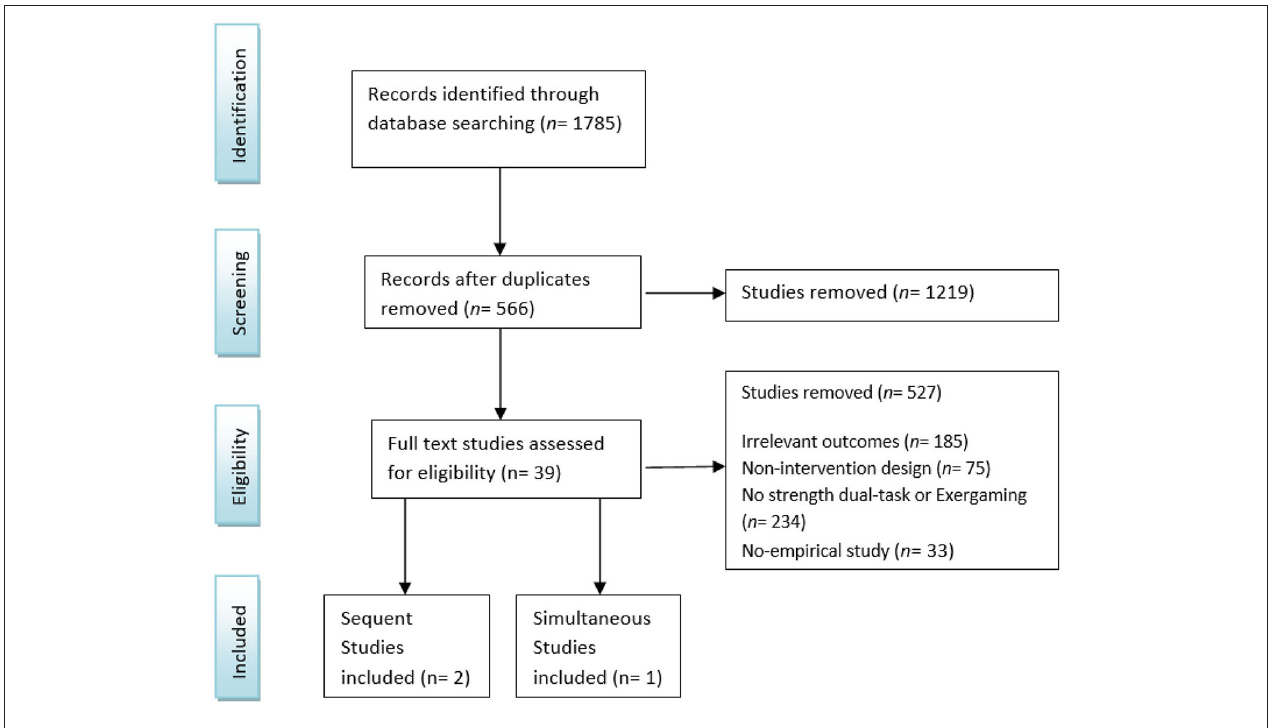
FIGURE 1 | Studies selection PRISMA flow chart.